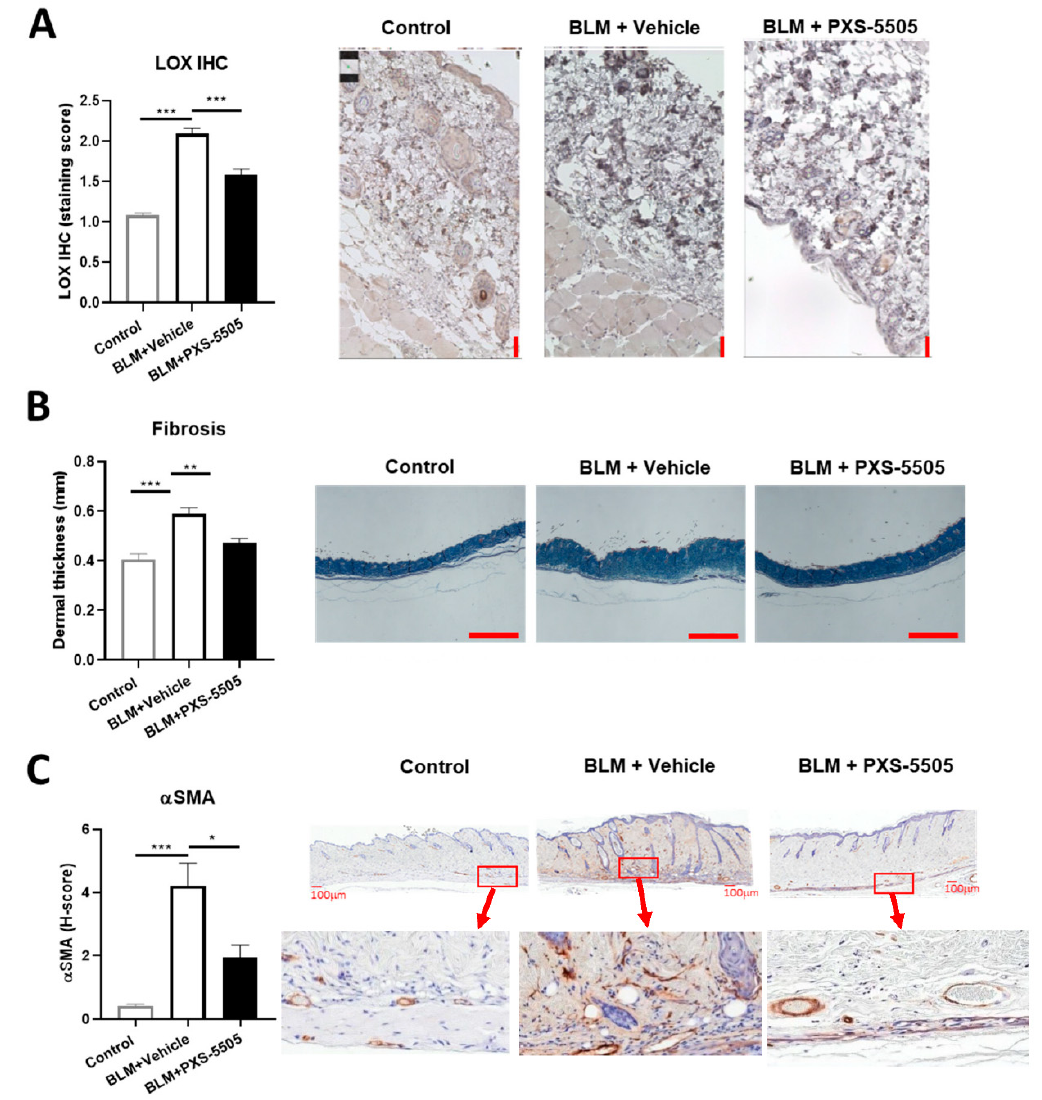
Figure 2. Effect of PXS-5505 treatment on intradermal bleomycin induced skin fibrosis. ( A ) Mice that received intradermal injection of bleomycin showed significantly higher LOX expression level in the skin that was ameliorated by PXS-5505 treatment. Skin slices were immunohistochemically stained against LOX and expression semi-quantified by scoring system. Scale bar = 50 µm. ( B ) Bleomycin treated mice showed significantly higher dermal thickness that was ameliorated by PXS-5505 treatment. Skin tissue slices were stained with Masson’s trichrome. Scale bar = 1000 µ m. ( C ) Bleomycin treated mice showed significant higher α -smooth muscle actin (SMA) level, which was ameliorated by PXS-5505 treatment. Skin slices were immunohistochemically stained against α -SMA and expression semi-quantified by H-scoring system. Scale bar = 100 µ m and 30 × magnification (* p < 0.05, ** p < 0.01, *** p < 0.001 between the indicated groups).